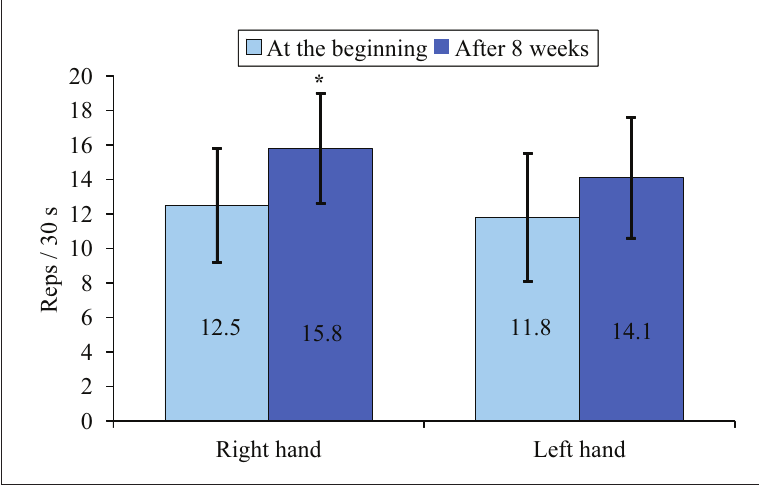
Note. * – statistically significant difference (p < 0.05).